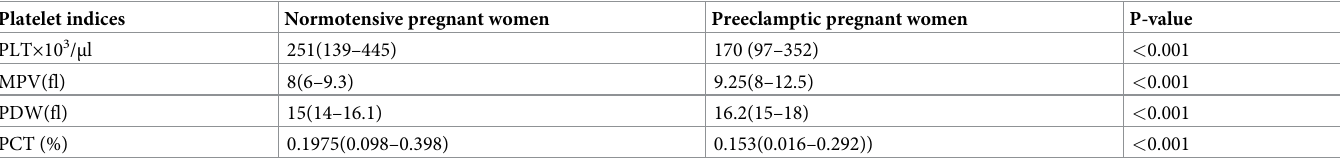
Where: PLT × 10 3 / μ l, Platelate in per microliter, MPV Mean Platelet Volume in femtoliter (fl), PDW (fl) Platelet Distribution Width in femtoliter and PCT (%) Platelate Crit in